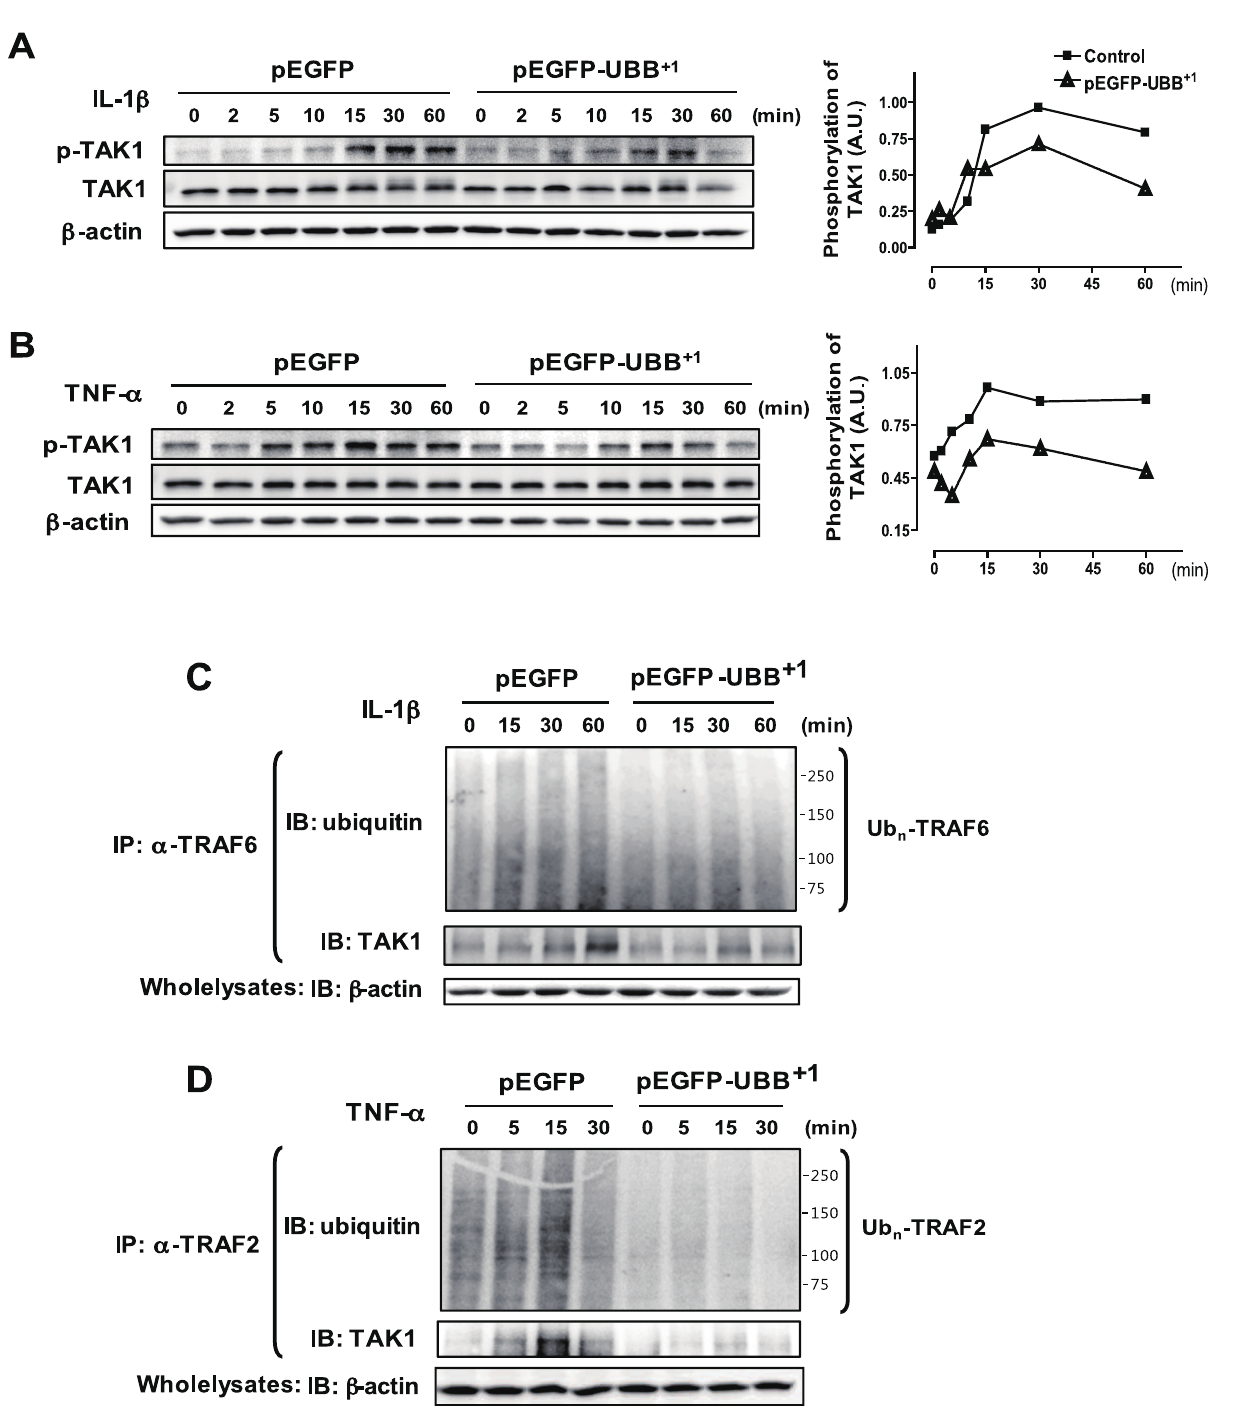
Figure 4. Inhibitory effect of UBB + 1 on IL-1 b - and TNF- a -induced TAK1 phosphorylation by polyubiquitylation of TRAF6 and TRAF2. CRT-MG cells stably expressing pEGFP or pEGFP-UBB + 1 were treated with IL-1 b (A) or TNF- a (B) for the indicated time periods. Cell lysates were examined by immunoblot analysis with antibodies to phospho-TAK1, TAK1 and b -actin. The relative amount of phosphorylated TAK1 was plotted over the time upon IL-1 b and TNF- a treatment in pEGFP-UBB + 1 stable cells (triangle) and pEGFP stable cells (square). Representative of three independent experiments. (C) Cells were treated with IL-1 b for the indicated time periods, and then lysates were precipitated with anti-TRAF6 and blotted with anti-Ub. The whole cell lysates were subject to immunoblot analysis with antibodies to TAK1 and b -actin. Smear of high molecular weight proteins by ubiquitin blots represent poly-ubiquitylated TRAF6. (D) Cells were treated with TNF- a for the indicated time periods, and then lysates were precipitated with anti-TRAF2 and blotted with anti-Ub. The whole cell lysates were examined by immunoblot analysis with antibodies to TAK1 and b -actin. Smear of high molecular weight proteins by ubiquitin blots represent poly-ubiquitylated TRAF2. Representative of two independent experiments.